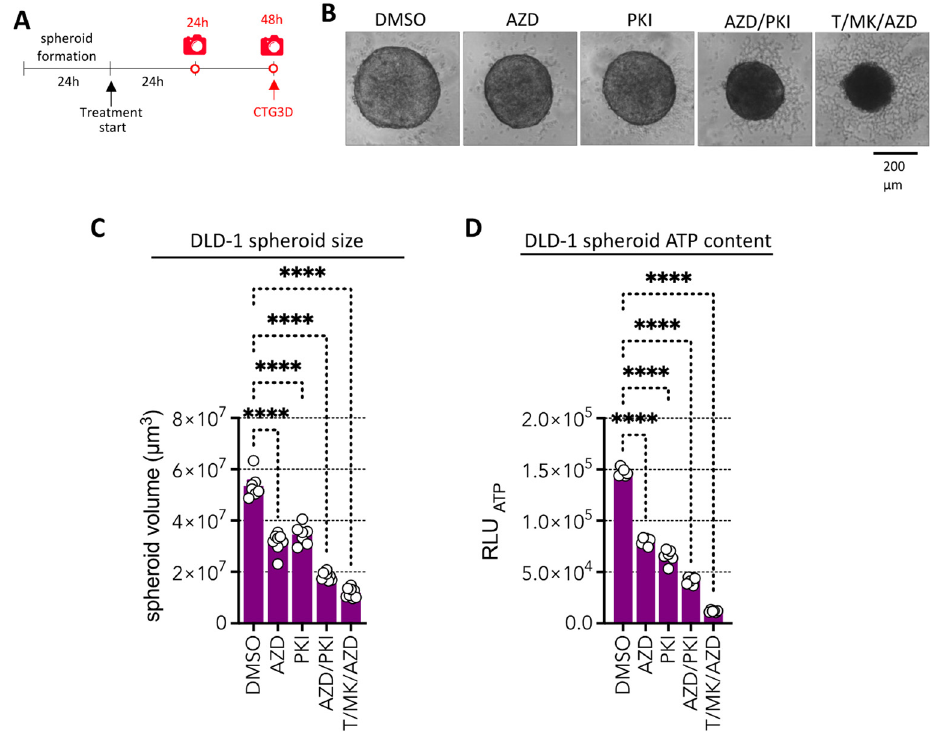
Figure 4. Impact of the pan PI3K/mTOR inhibitor gedatolisib (PKI-587, PF 05212384) alone or combined with AZD on DLD-1 spheroids in comparison to T/MK7AZD. ( A ) Overview of the time frame of the experiment. ( B ) Representative phase contrast images of DLD-1 spheroids treated for 48 h with the indicated inhibitors. ( C ) Spheroid volume after 48 h of treatment. ( D ) Cellular ATP levels determined with CellTiter-Glo 3D (CTG3D) after 48 h of spheroid treatment. Luminescence values (RLU ATP ) were determined ( n = 6 per condition). Bar graphs are mean + standard deviation (SD); individual values are shown (circles). p values are indicated by